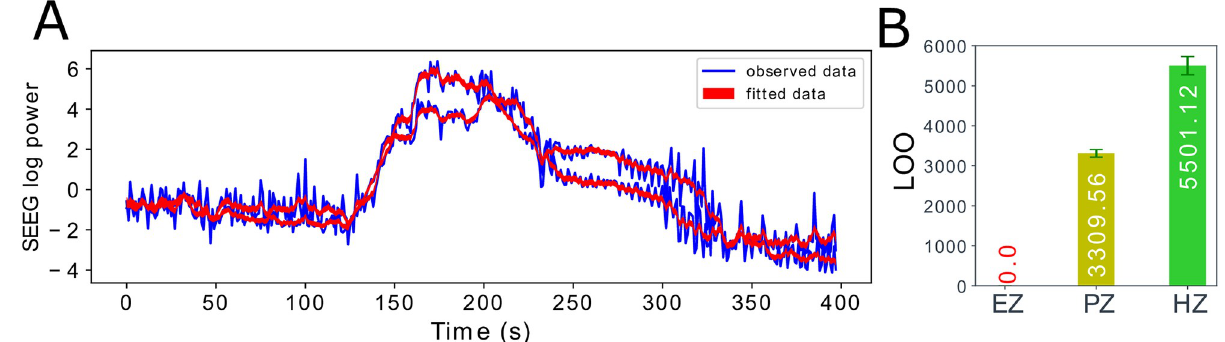
Fig 7. Model fitting against empirical SEEG recordings and EZ hypothesis evaluation using fully Bayesian information criteria. ( A ) SEEG log power of two implanted intracranial electrodes (in blue) versus the fitted envelope from BVEP model inversion (in red). ( B ) LOO cross-validation for the three hypotheses testing about clinical hypothesis (left Amygdala) as EZ, PZ, and HZ and their Delta scores (white text). Delta score of zero indicates the best hypothesis (EZ), whereas the alternative hypotheses (PZ and HZ) have essentially no